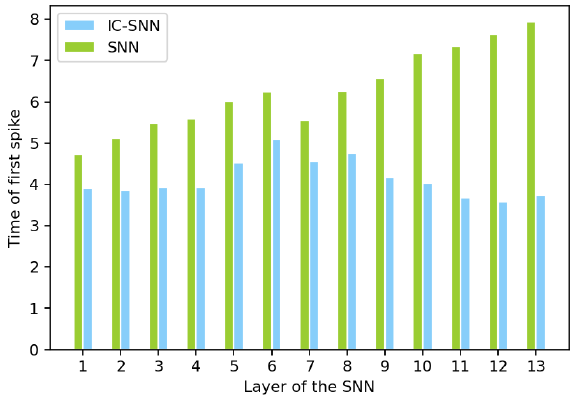
Figure 6. Spike firing time of